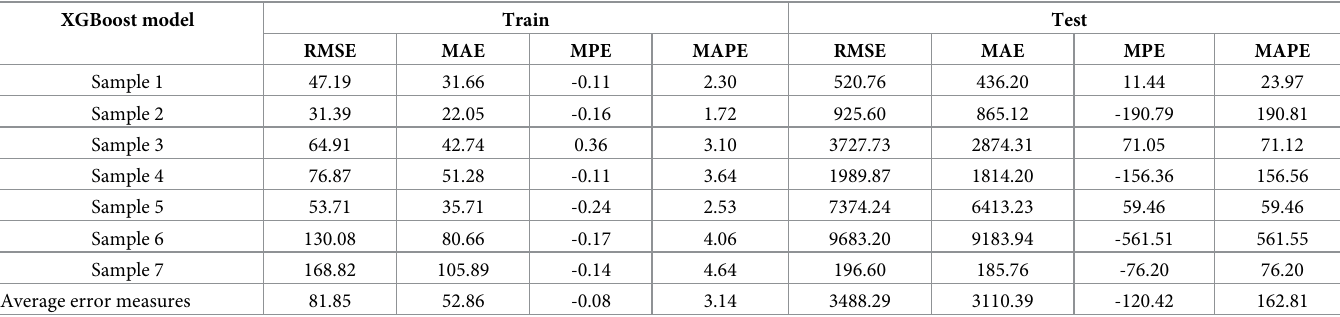
Table 3. Evaluation of parameters for the XGBoost model of different training and test sets for COVID-19 confirmed cases. XGBoost model Train